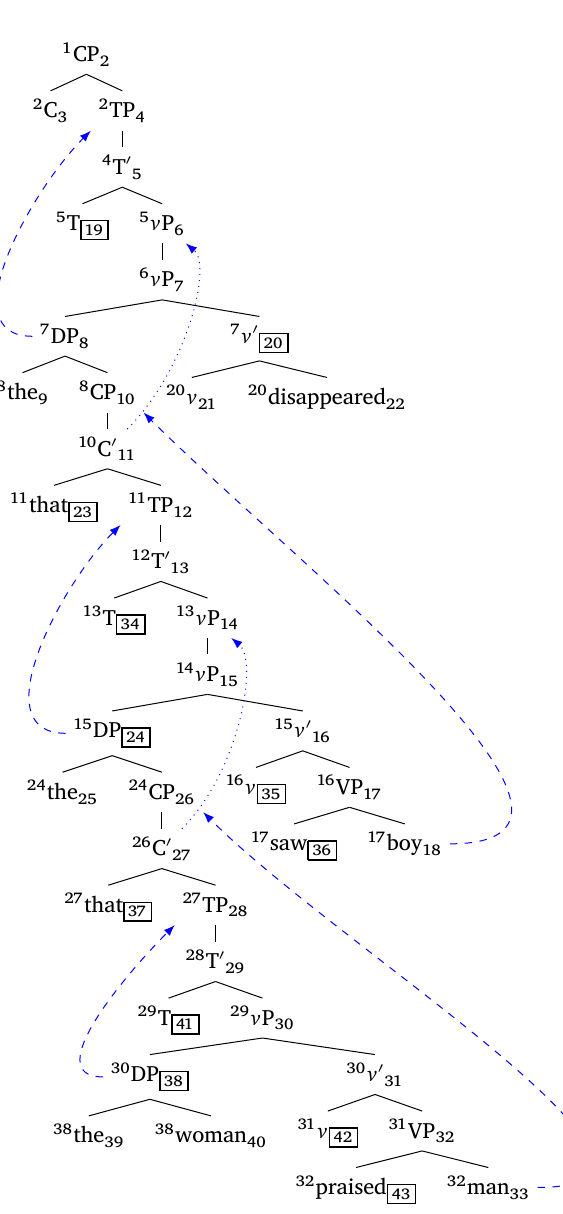
Figure 14: Right embedding, promotion